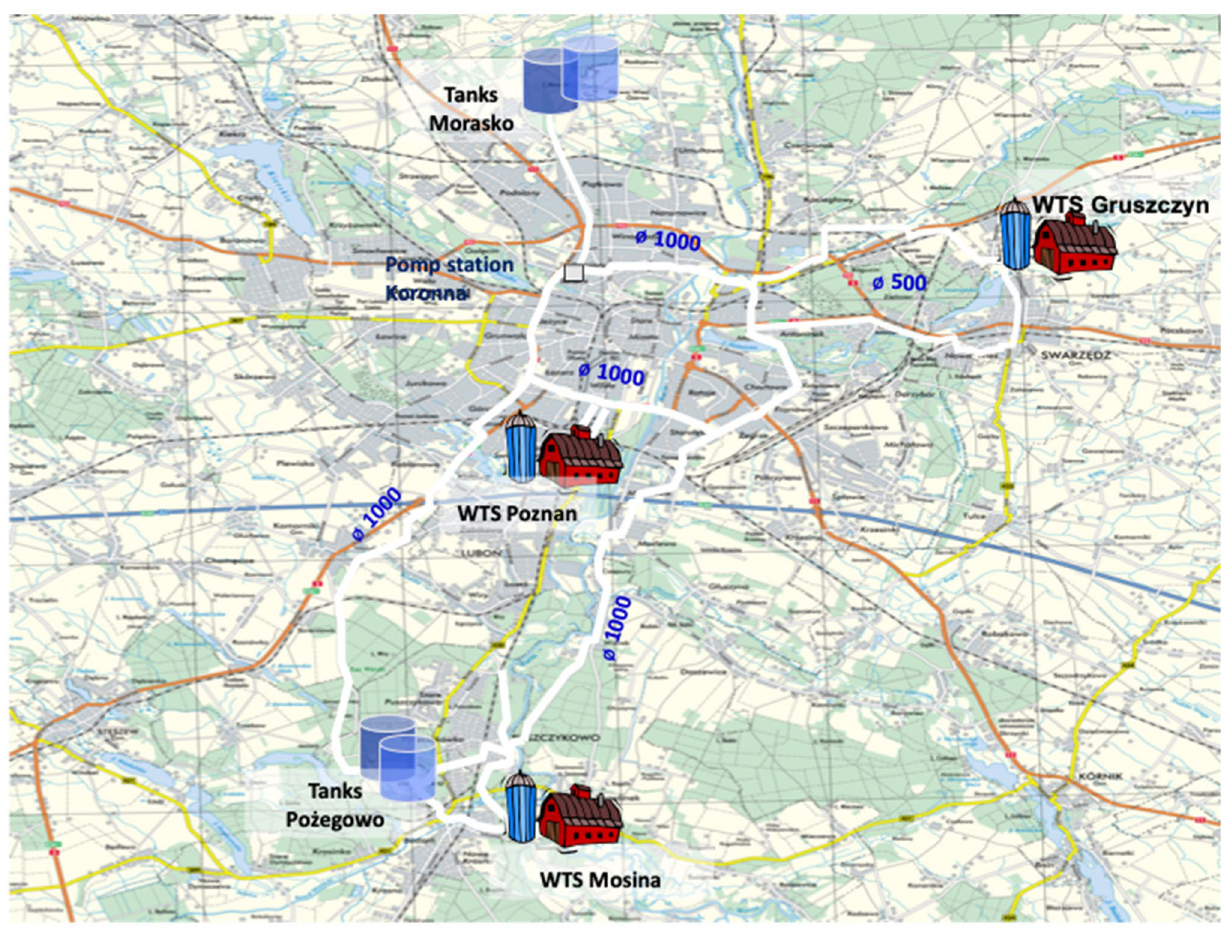
Fig. 1 Scheme of the Poznań water supply system with marked locations of intakes, stations and storage